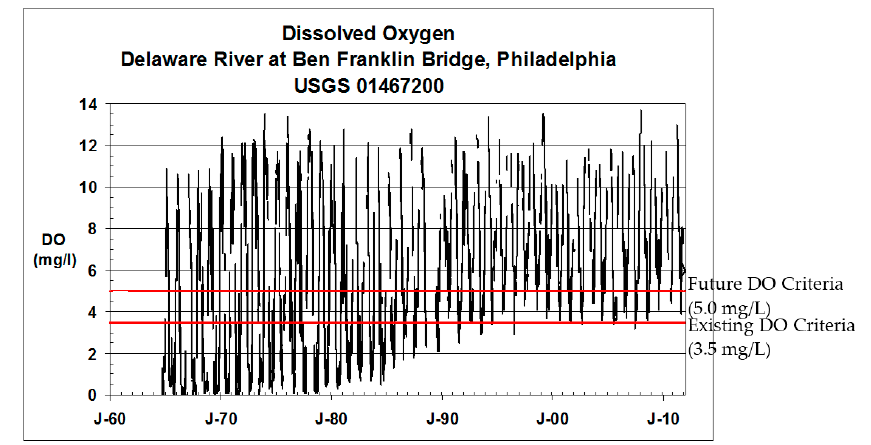
Figure 3. Mean Daily Dissolved Oxygen (DO) at Ben Franklin Bridge along Delaware River.